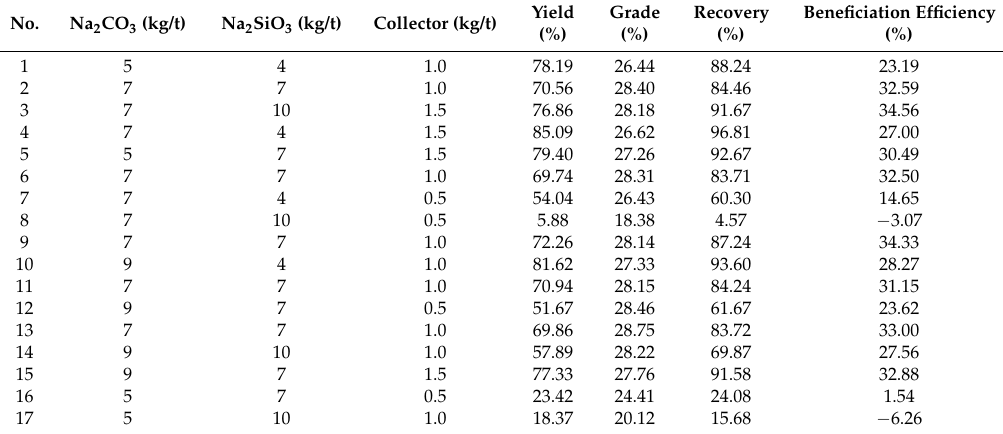
Table 6. Experimental scheme and flotation